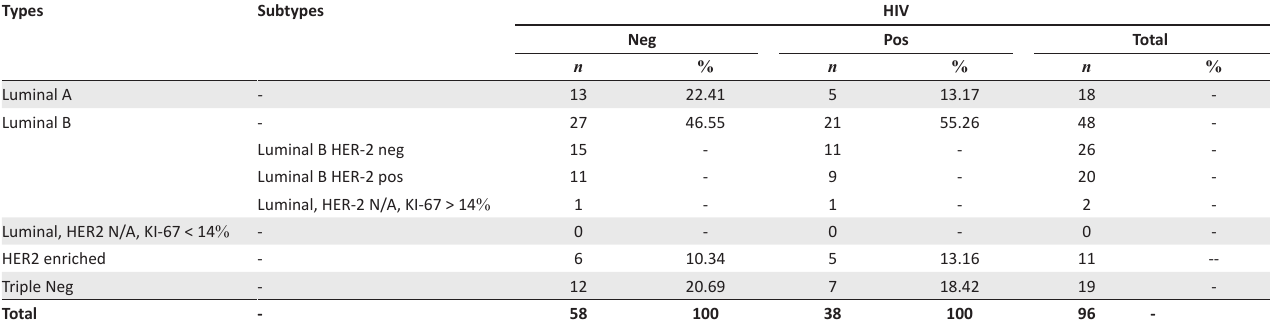
TABLE 5: Molecular subtype by human immunodeficiency virus status.